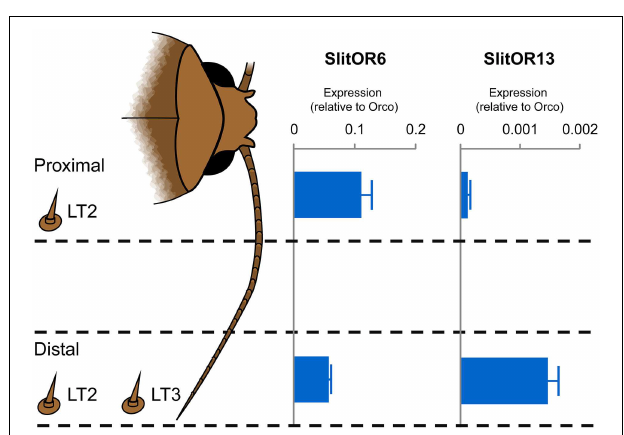
FIGURE 3 | Relative expression levels of SlitOR6 and SlitOR13 in the proximal and the distal parts of the S. littoralis male antennae. Expression levels have been normalized to the expression of the obligate olfactory co-receptor ORco. The occurrence of the LT2 and LT3 trichoid sensilla in the proximal and distal parts is also indicated. Error bars indicate standard